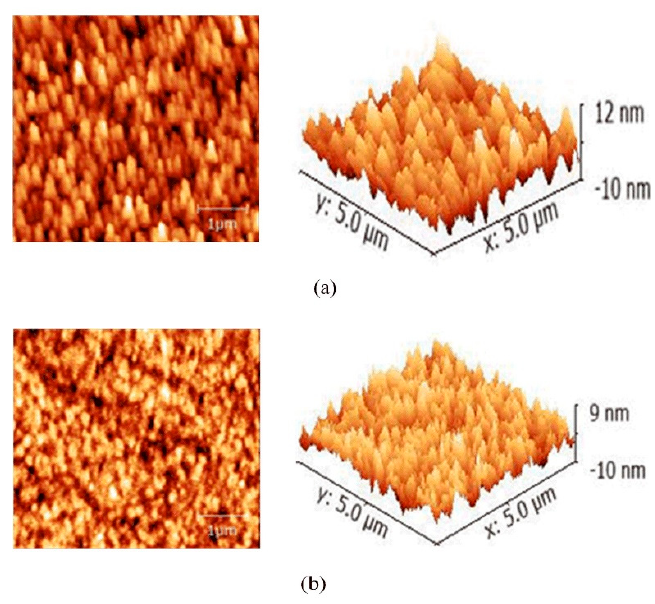
Figure 5. ( a ) Surface morphologies of ( a ) ITO/ZnO (aqueous) and ( b ) ITO/ZnO (sol-gel).